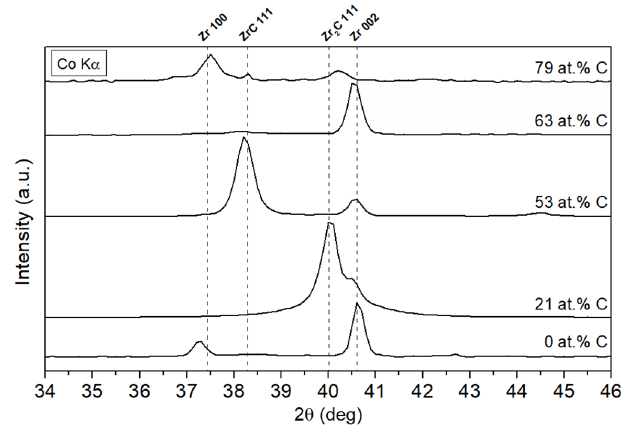
Figure 5. X-ray diffractograms of Zr–C coatings at various concentrations of carbon.